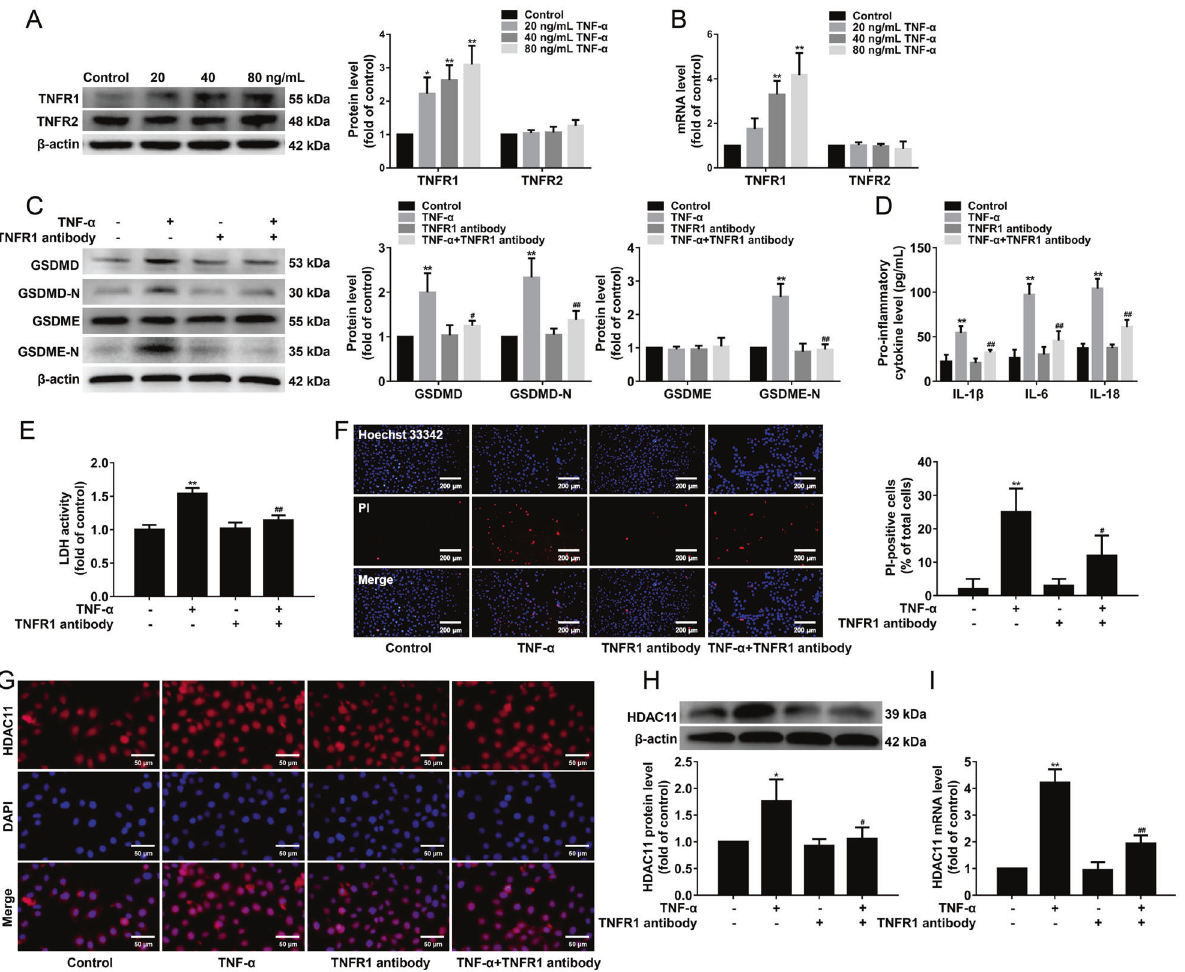
Fig. 3 Blockade of TNFR1 inhibits pyroptosis and downregulates HDAC11 expression in TNF- α -induced HUVECs. HUVECs were treated with TNF- α (20, 40, or 80 ng/mL) for 12 h. A , B The expressions of TNFR1 and TNFR2 protein and mRNA were determined by Western blotting and quantitative real-time PCR, respectively. The HUVECs were pretreated with a TNFR1 neutralizing antibody (5 µg/mL) for 30 min and then stimulated with TNF- α (40 ng/mL) for 12 h. C The protein expressions of GSDMD, GSDMD-N, GSDME, and GSDME-N were determined by Western blotting. D The levels of IL-1 β , IL-6, and IL-18 in the cellular supernatant were detected by ELISA assay. E The cellular supernatant LDH level was evaluated with a cytotoxicity detection LDH kit. F The representative photographs of double- fl uorescent staining with PI (red) and Hoechst 33342 (blue), and the quanti fi cation of PI-positive cells, ×100. Scale bar indicates 200 μ m. G Immuno fl uorescence staining was performed to determine the expression and localization of HDAC11, ×200. Scale bar indicates 50 μ m. H , I The protein and mRNA expressions of HDAC11 were determined by Western blotting and quantitative real-time PCR. ** P < 0.01, vs. NC siRNA group; # P < 0.05, ## P < 0.01 vs. NC siRNA + TNF- α group. Results are expressed as mean ± SD ( n =